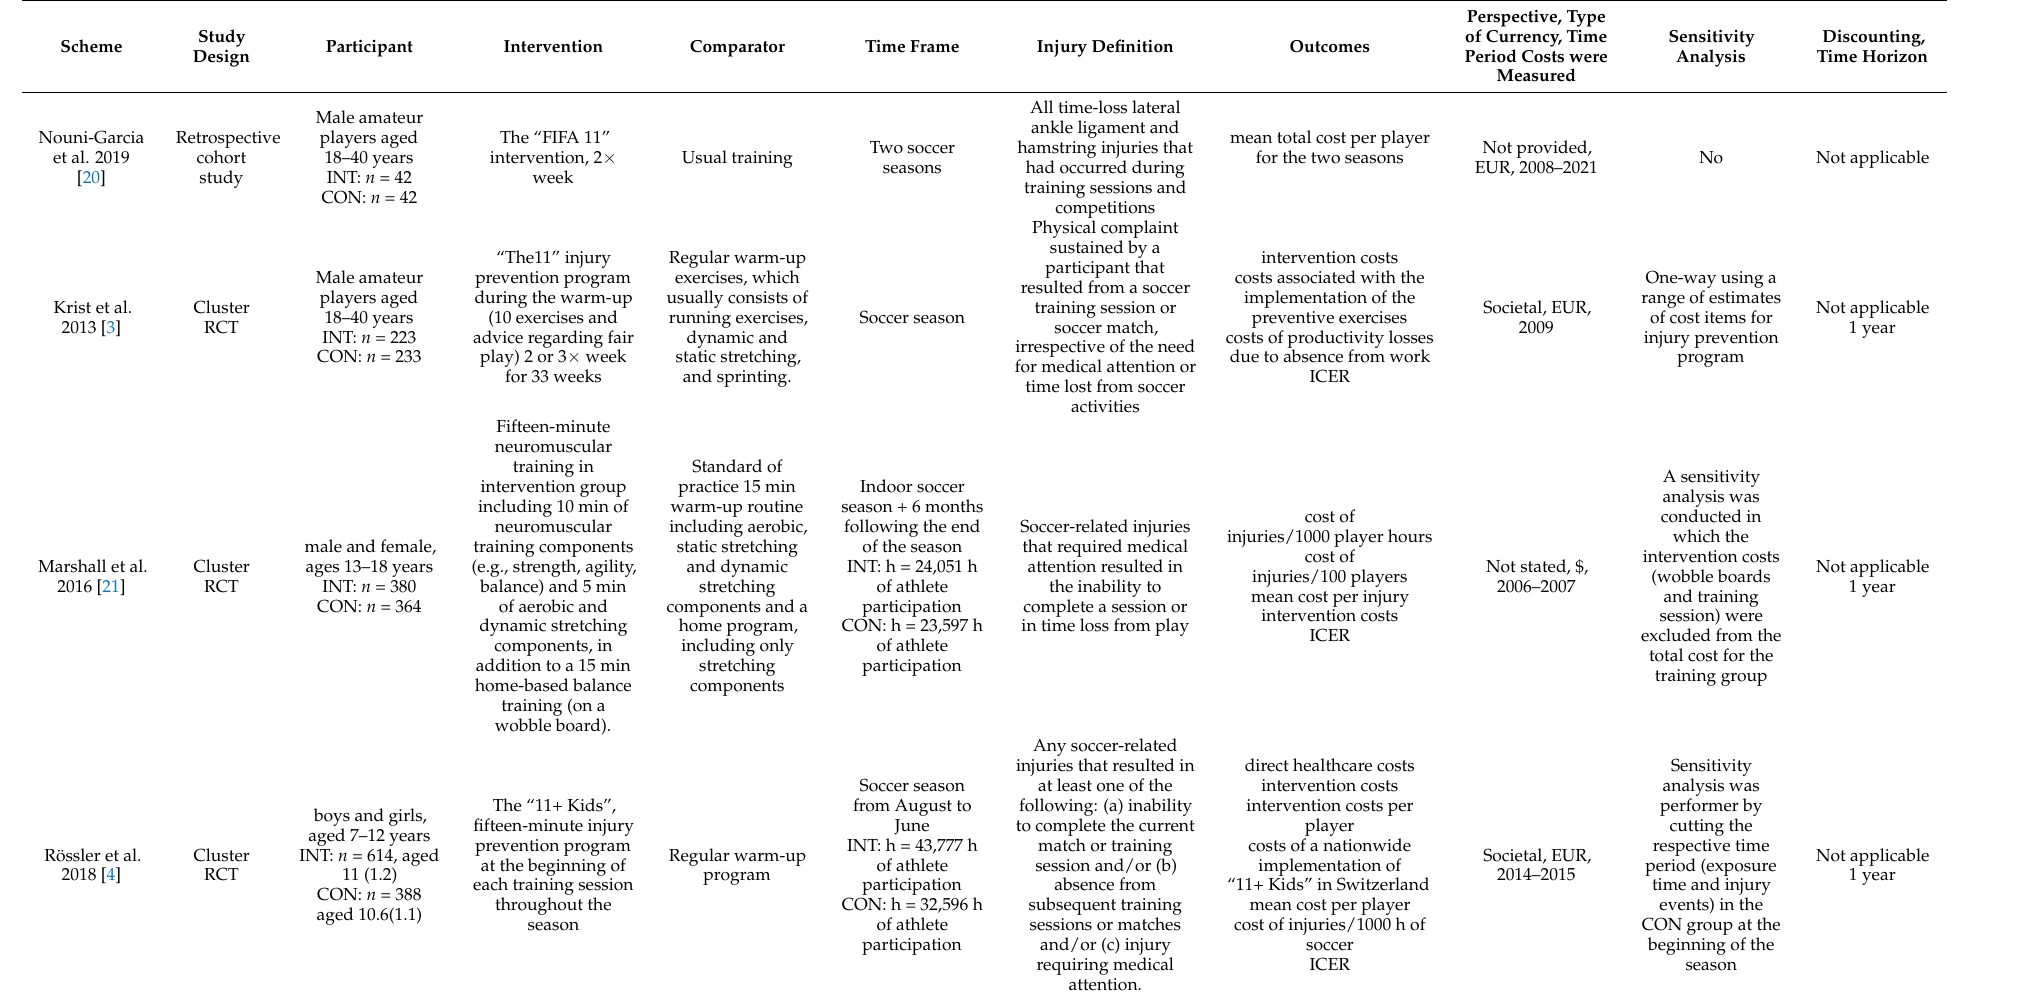
Table 2. Studies’